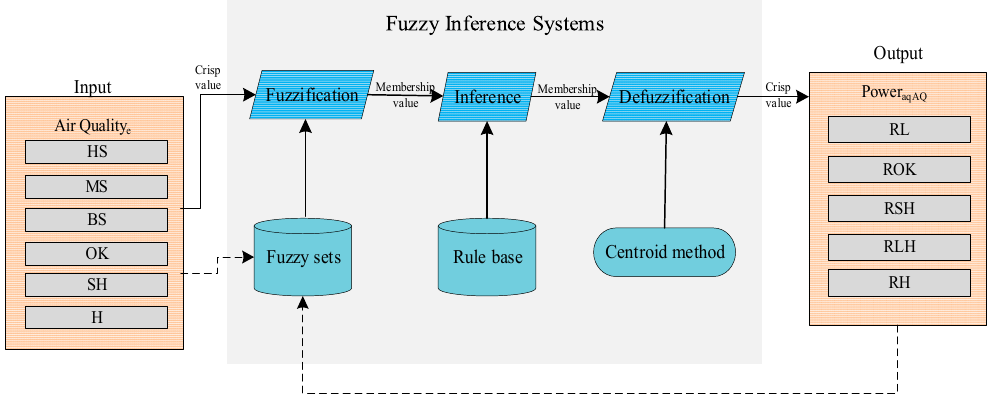
Figure 16. Structure diagram for air quality fuzzy controller.